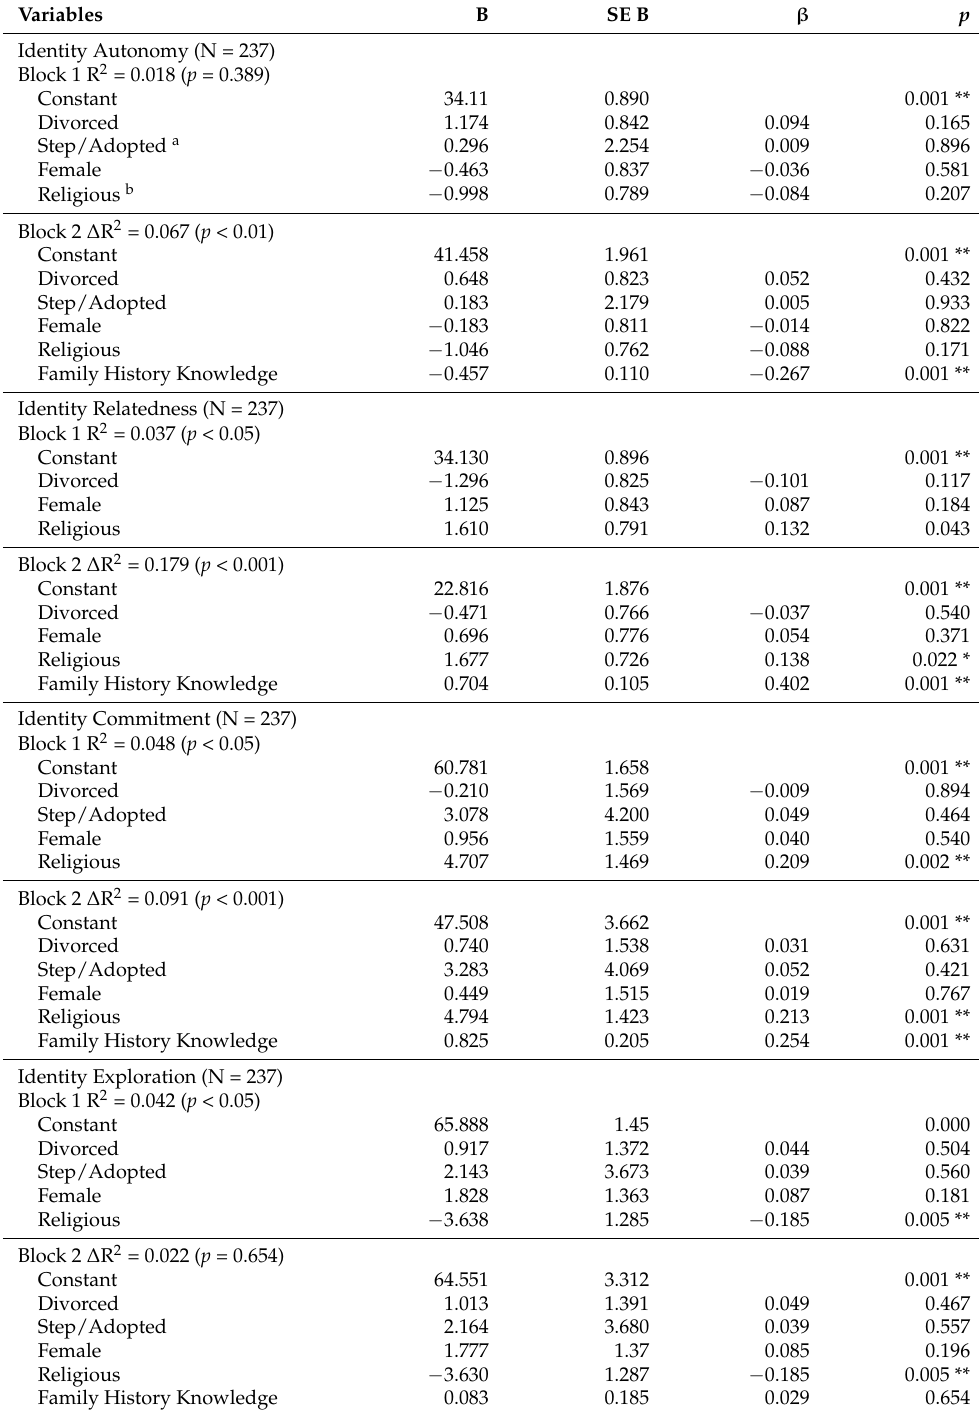
Table 1. Summary of Multiple Regression Equations.